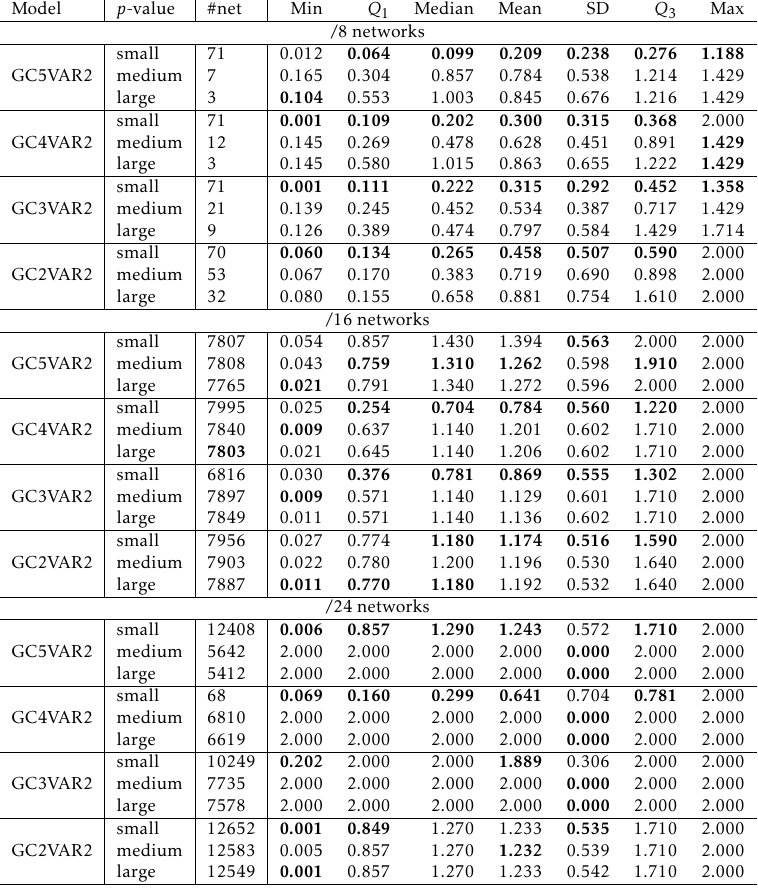
Table 5. Summary statistics of the SMAPE values for / 8 , / 16 and / 24 networks (#net is the # of networks involved), where bold-font highlights the most accurate predictions among the different p -values with respect to a specific model.